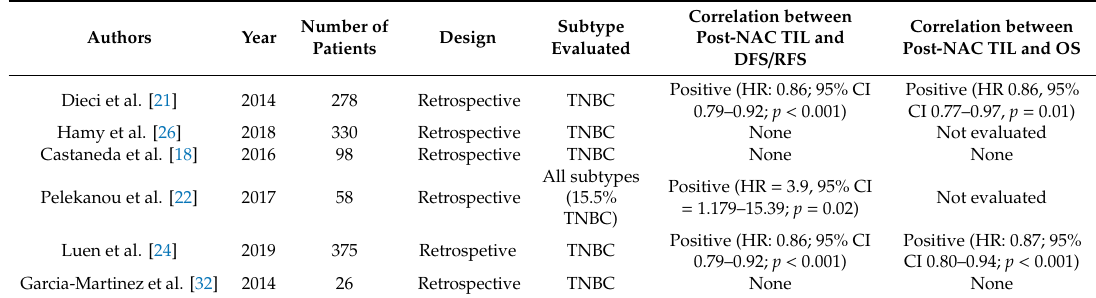
Table 3. Main studies evaluating the impact of post-NAC TIL on DFS / recurrence-free survival (RFS) and OS in